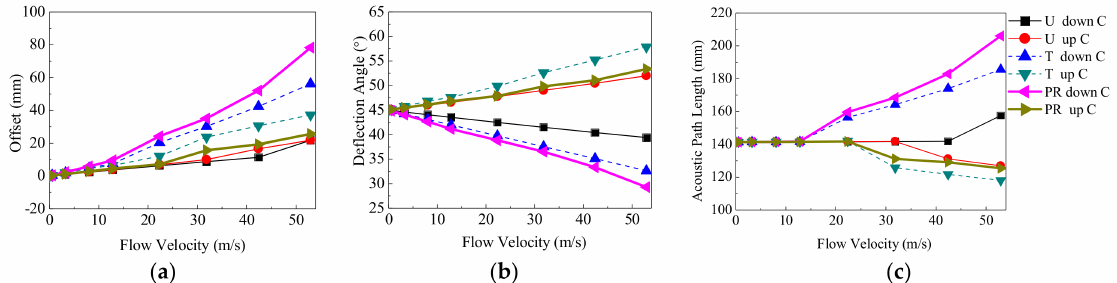
Figure 14. Receiving features of the central ray in different flow patterns. ( a ) Offset ( ∆ l dC , ∆ l uC ). ( b ) Deflection angle ( α dC , α uC ). ( c ) Length of ray path ( l dC , l uC ).